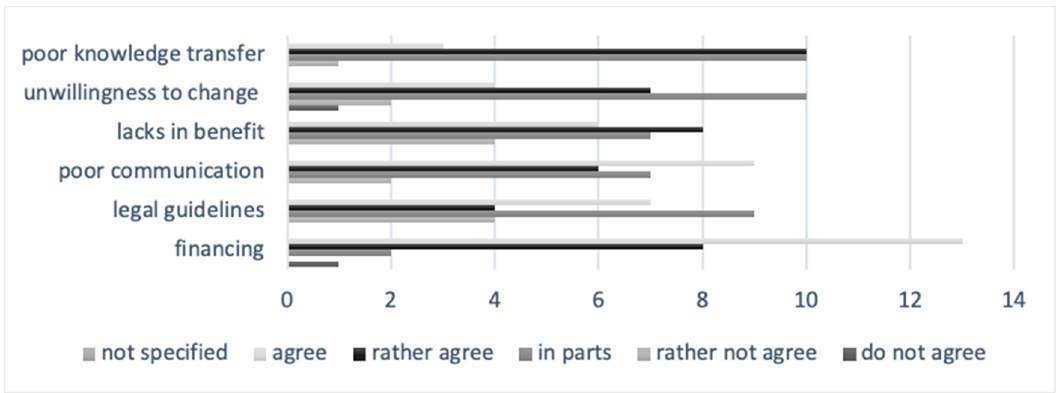
Figure 3. Most important obstacles in IPs (Delphi 2, n = 24 total number of mentions, own figure, based on [33].